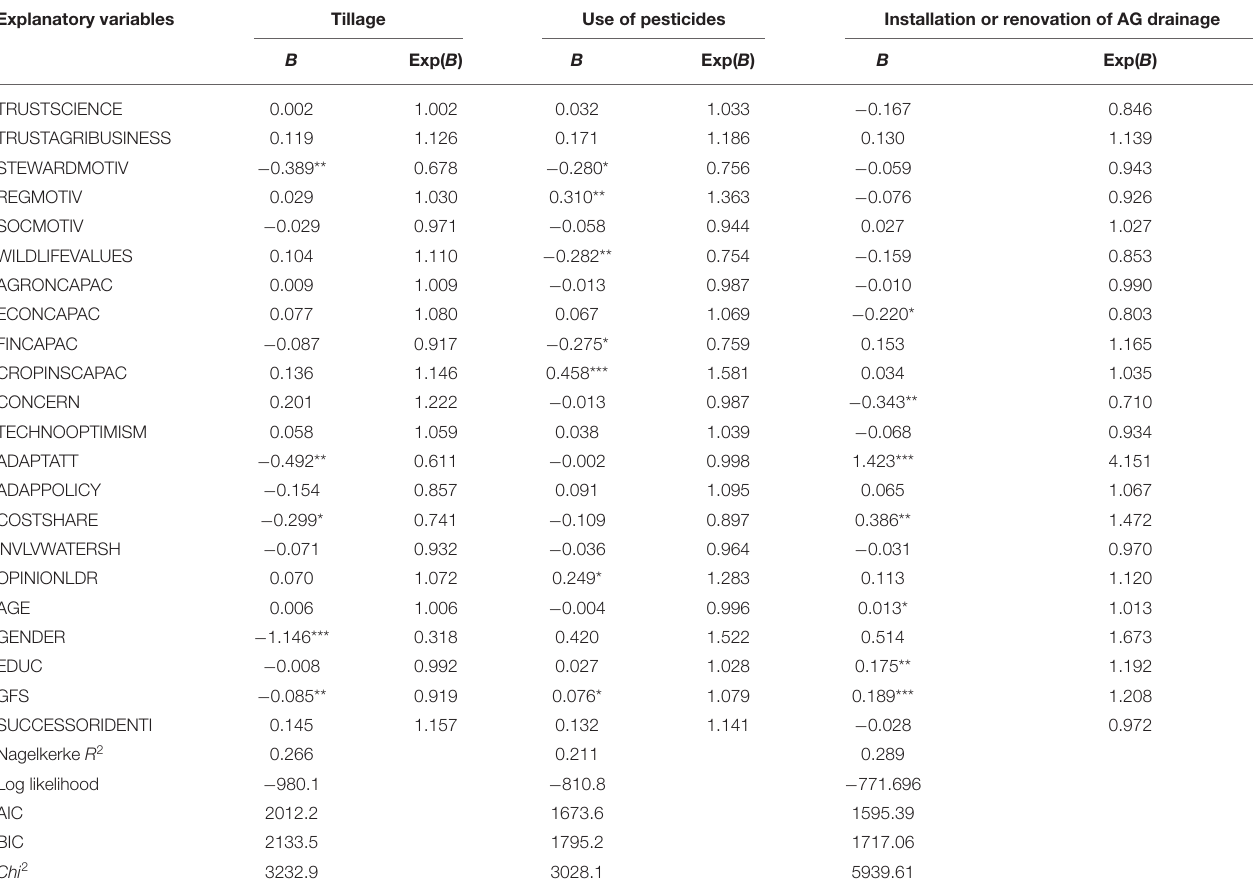
TABLE 4 | Factors that affect farmers’ maladaptive actions to climate change and extreme weather impacts. Explanatory